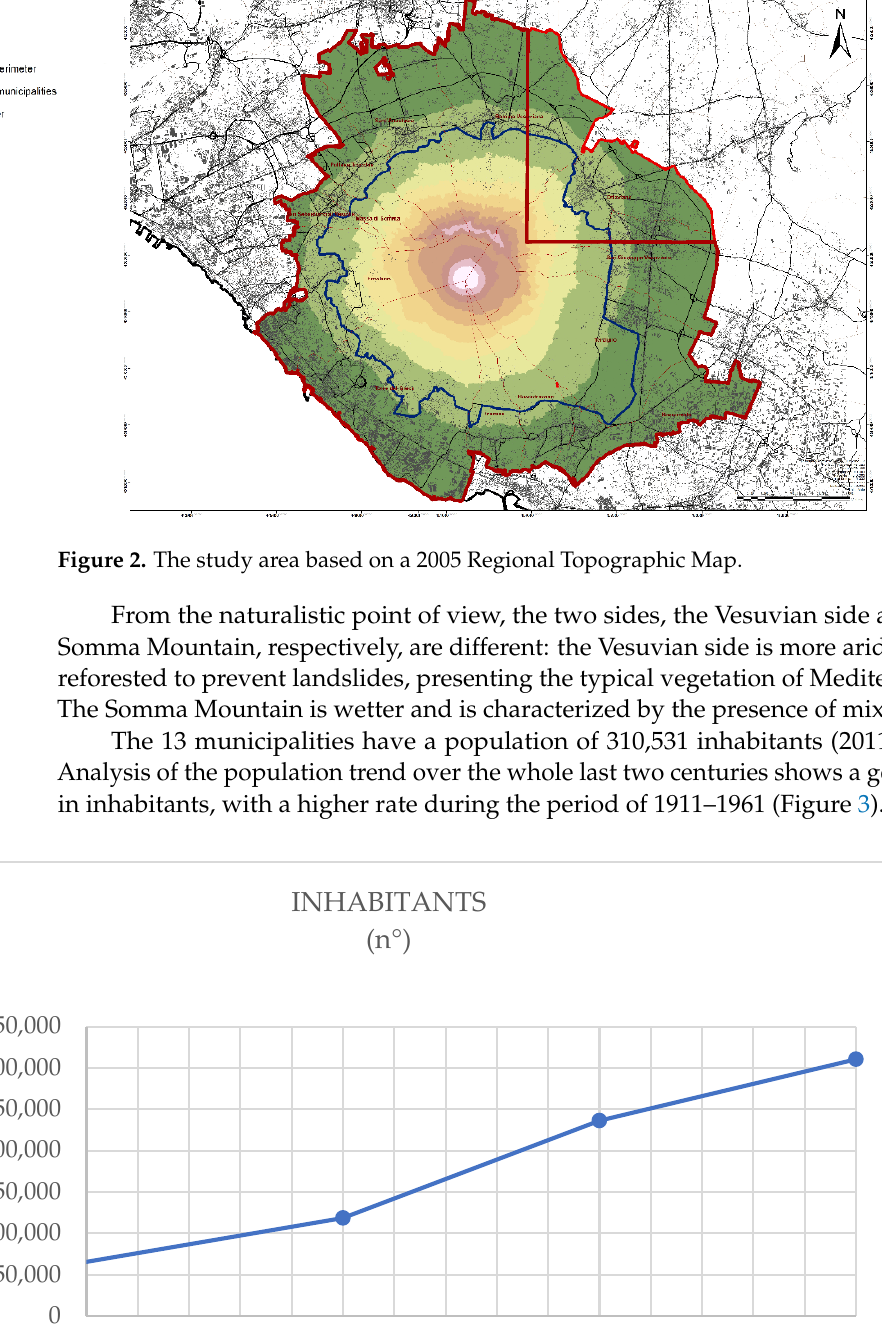
Figure 3. Resident population growth from 1861 to 2011; ISTAT Census data of 1861, 1911, 1961, 2011.